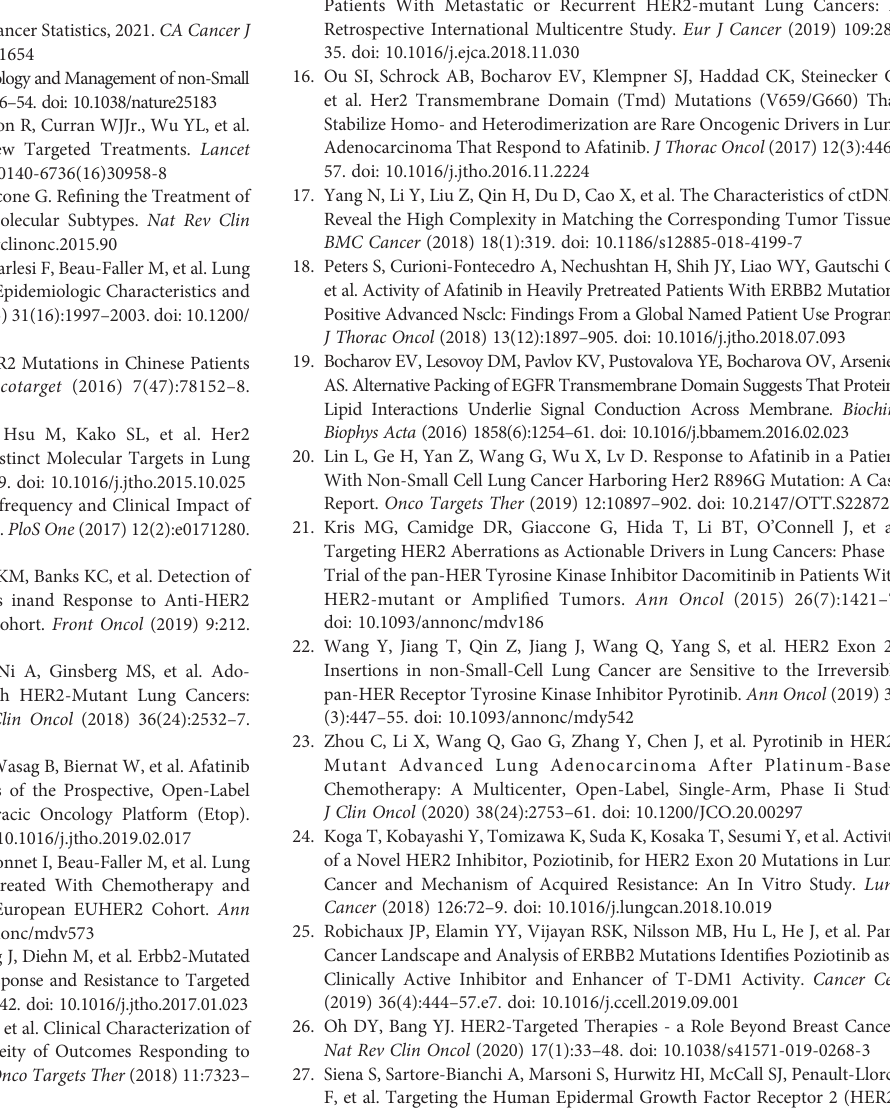
Supplementary Figure 1 | Next-generation sequencing result showed a HER2 Y772_A775dup mutation. The BAM fi le was viewed using integrative genomics viewer. Supplementary Figure 2 | Kaplan-Meier estimates of progression-free survival andoverallsurvival accordingto HER2 mutations. (A) progression-free survival; (B) overall survival. Supplementary Figure 3 | Kaplan-Meier estimates of progression-free survival and overall survival according to lines of treatment. (A) progression-free survival; (B) overall